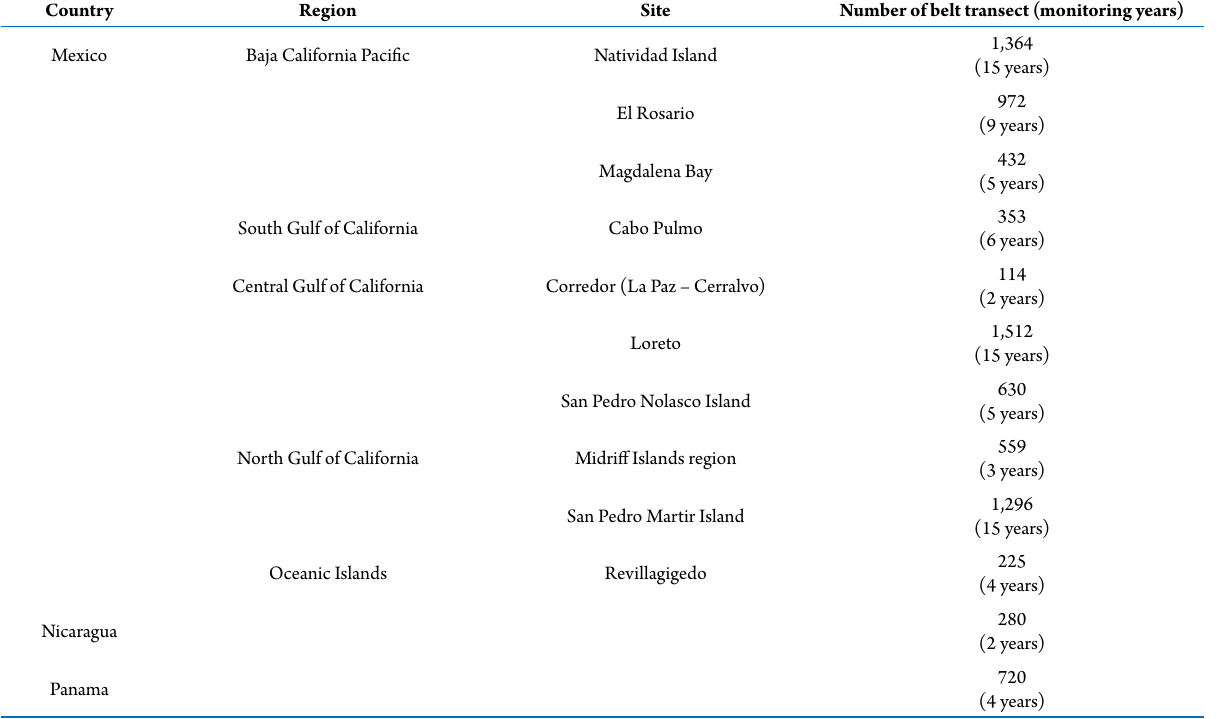
Table 2. Macroinvertebrate censuses carried out by country, region and site